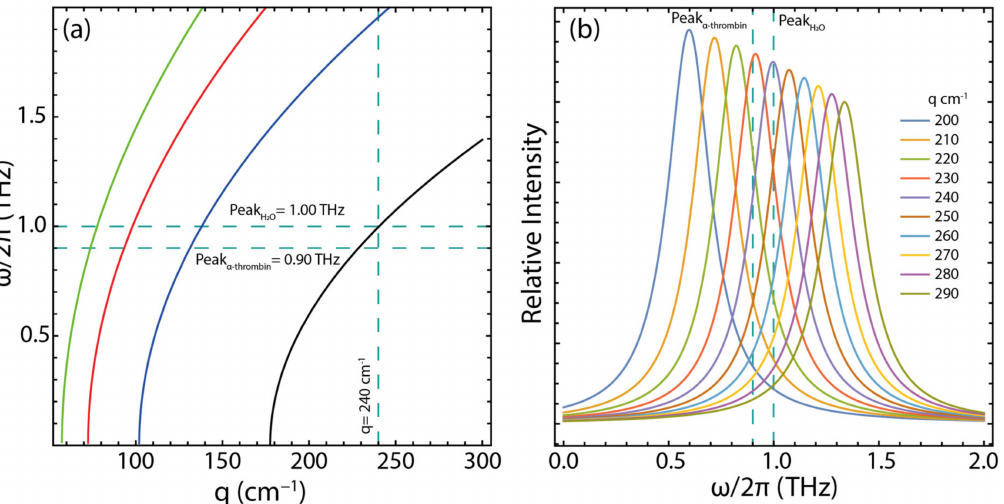
Figure 11. ( a ) Plasmon frequency–momentum dispersion ( ≤ 2 THz) for different ribbon widths (155, 270, 380, and 480 nm). ( b ) Maximum of the plasmon peak for w = 155 nm for selected